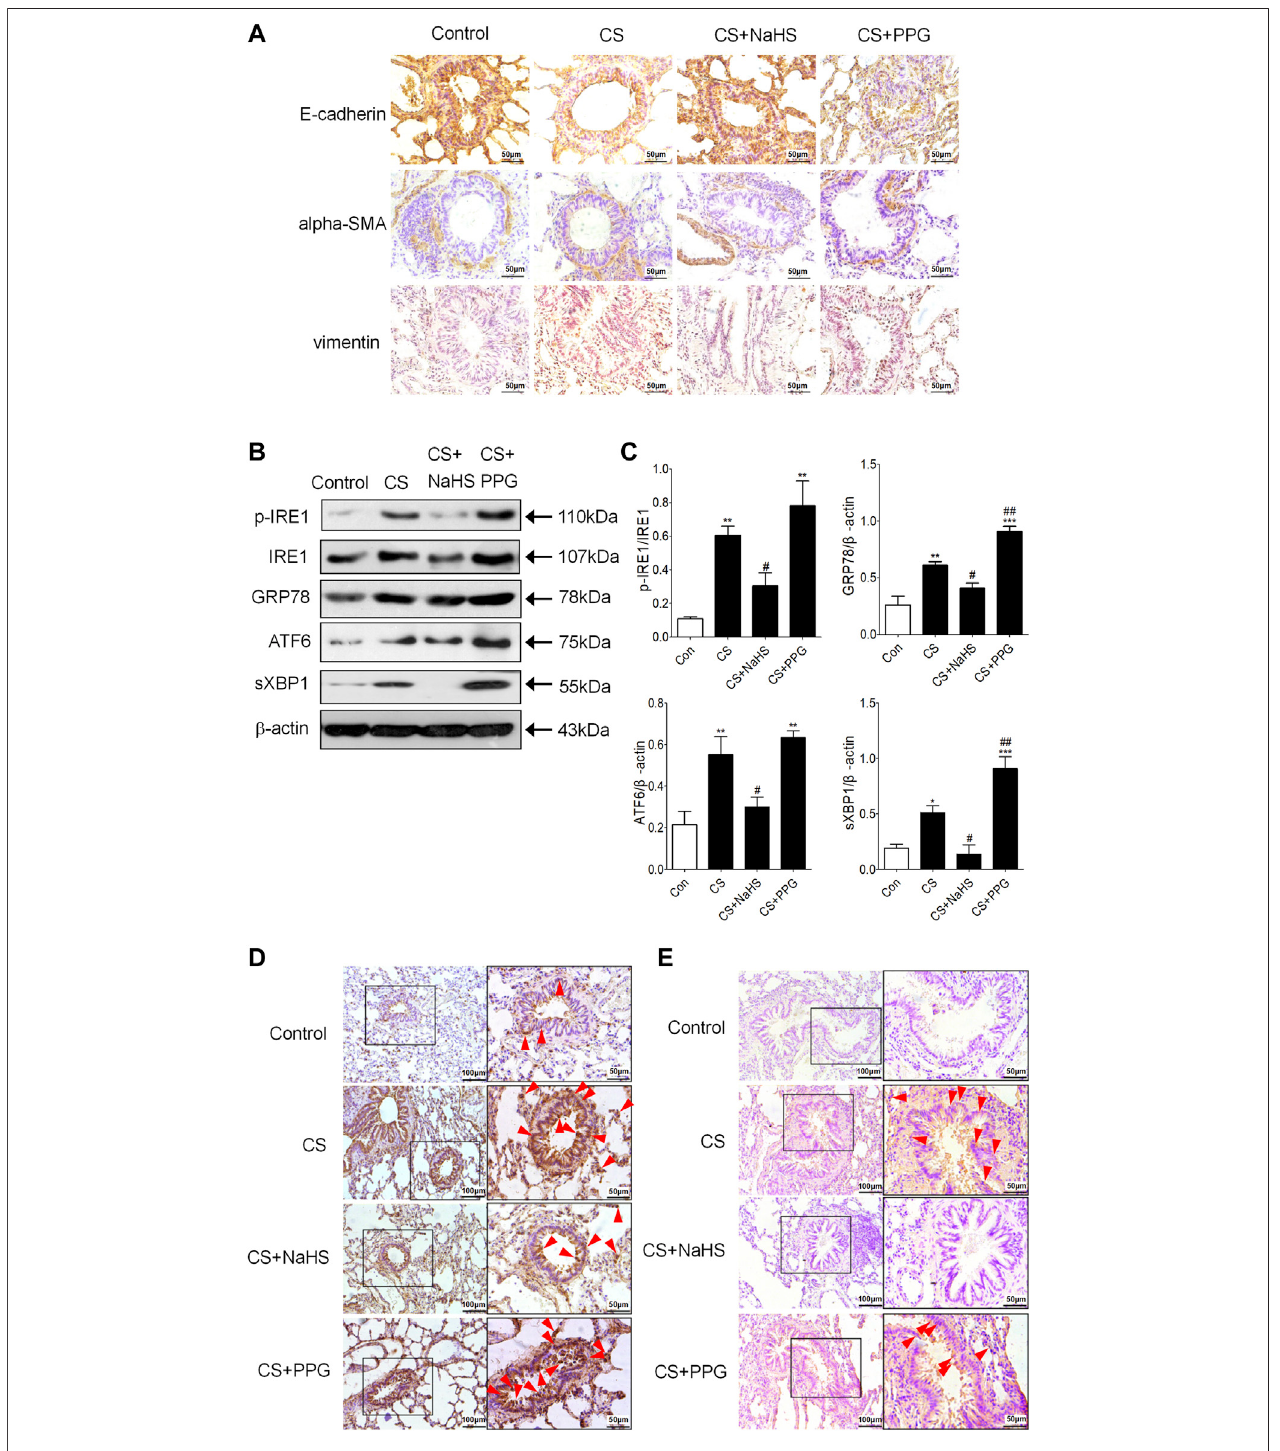
FIGURE3| EndogenousH 2 SprotectsagainstEMTandERstressinthelungtissuesofCS-exposedrats. (A) E-cadherinislocalizedtotherespiratoryepithelialcell. Comparedwiththecontrolgroup,E-cadherinwaslighterintheCSgroupand thePPG+CSgroup. TheNaHS+CSgrouphad moreintenseE-cadherin compared with the CS group. Alpha-SMA is localized in the cytoplasm of mesenchymal cells, and Vimentin is localized in the cytoplasm of mesenchymal cells and epithelial cells. Comparedwiththecontrolgroup,alpha-SMAandVimentinweremoreintenseintheCSgroupandthePPG+CSgroup,especiallyinbronchialepithelialcells.The NaHS +CSgrouphadlighteralpha-SMAandVimentincomparedwiththeCSgroup. (B,C) WesternblottinganalysisofERstressesmarkersp-IRE1,GRP78,ATF6and sec-XBP1 protein expression in the lung homogenates of rats. Results are presented of 3 independent experiments ( n = 3). Values are expressed as mean ± SEM. * p <